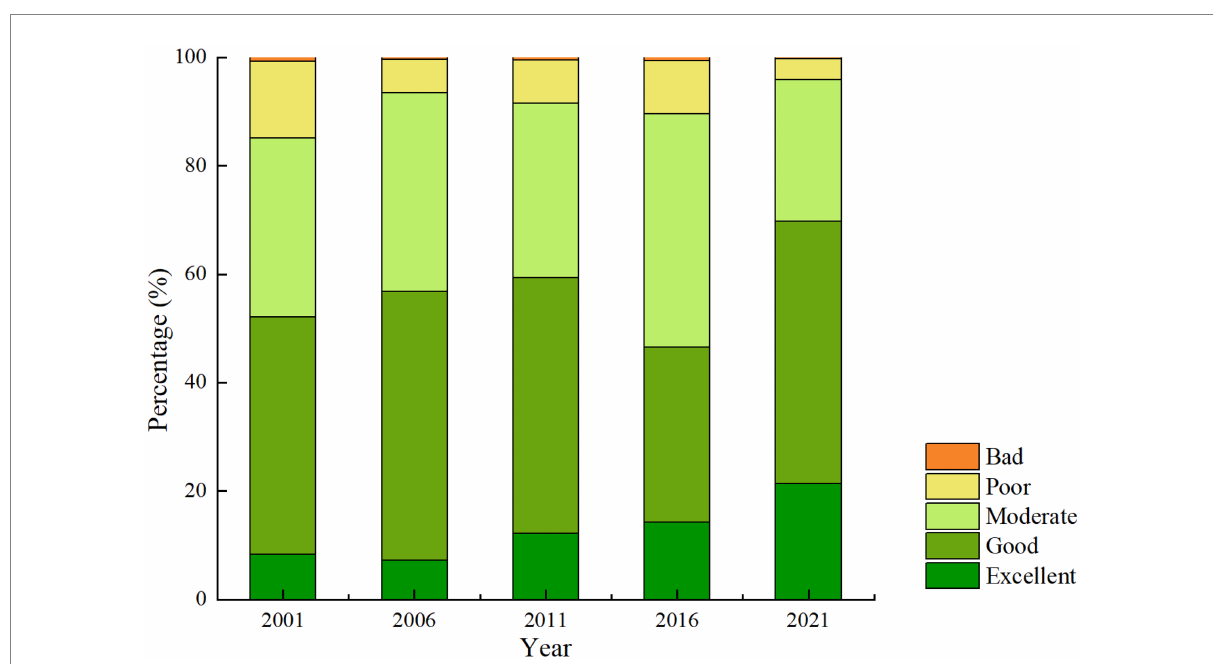
FIGURE 4 Area distribution of ecological environment quality levels in study area From 2001 to